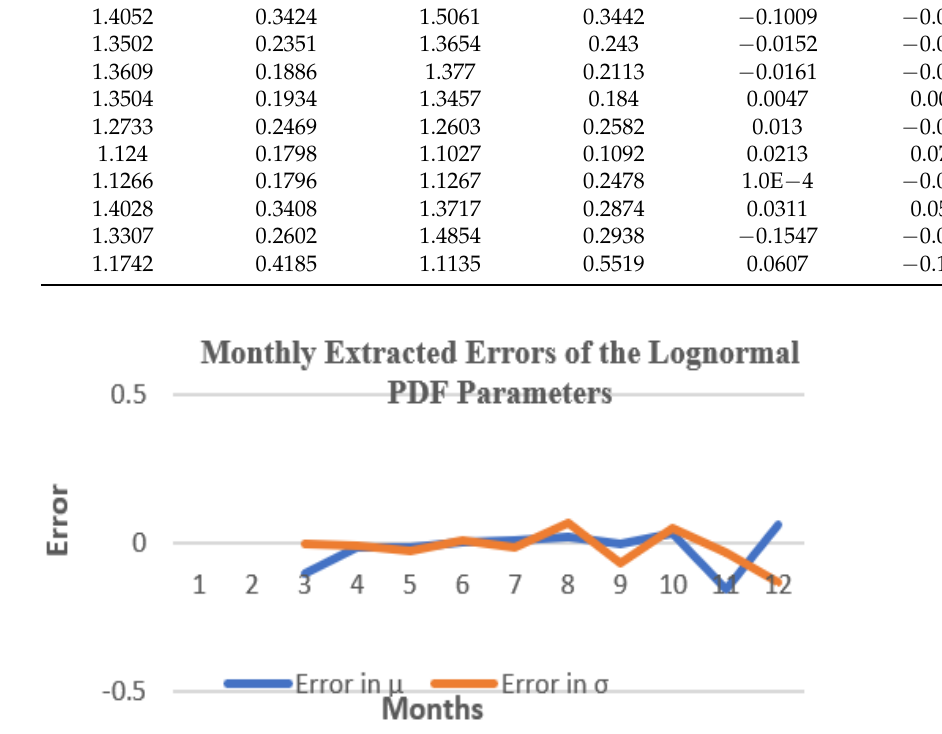
Figure 13. Extracted errors of Lognormal PDF two parameters μ and σ .